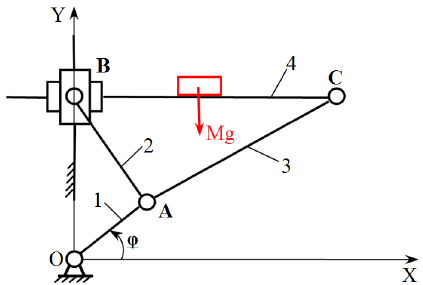
Figure 1. Structural scheme of orthogonal mechanism of